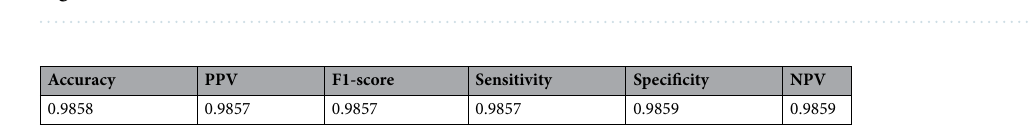
Figure 1. Swin-transformer network.